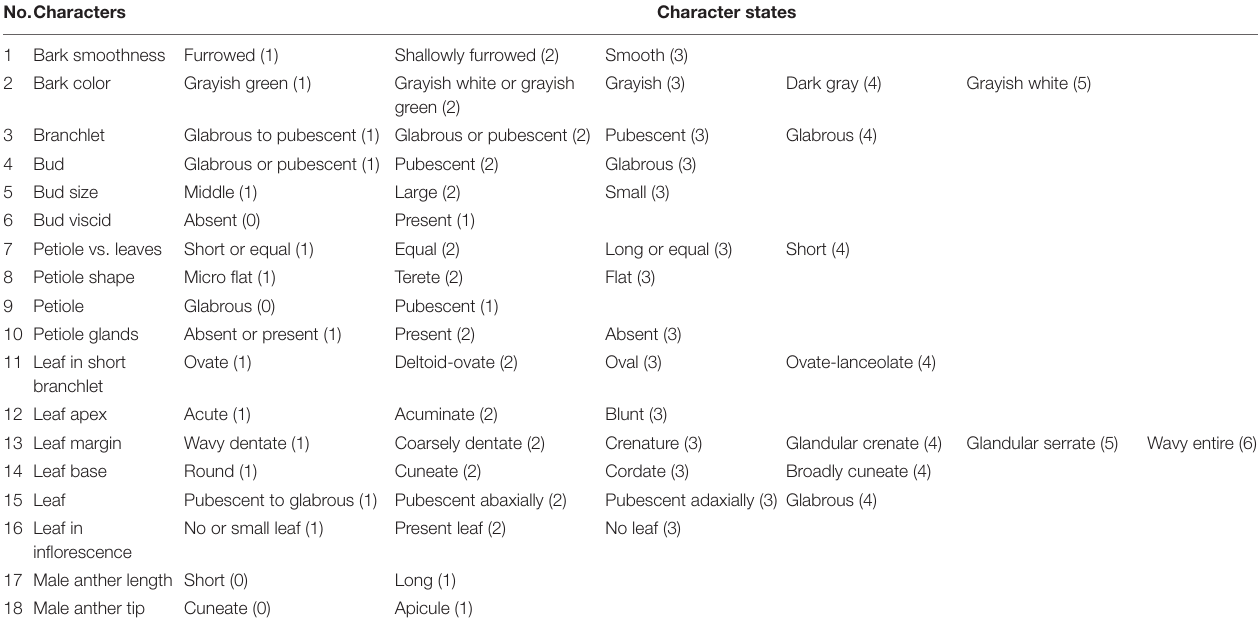
TABLE 2 | Character coding for morphological